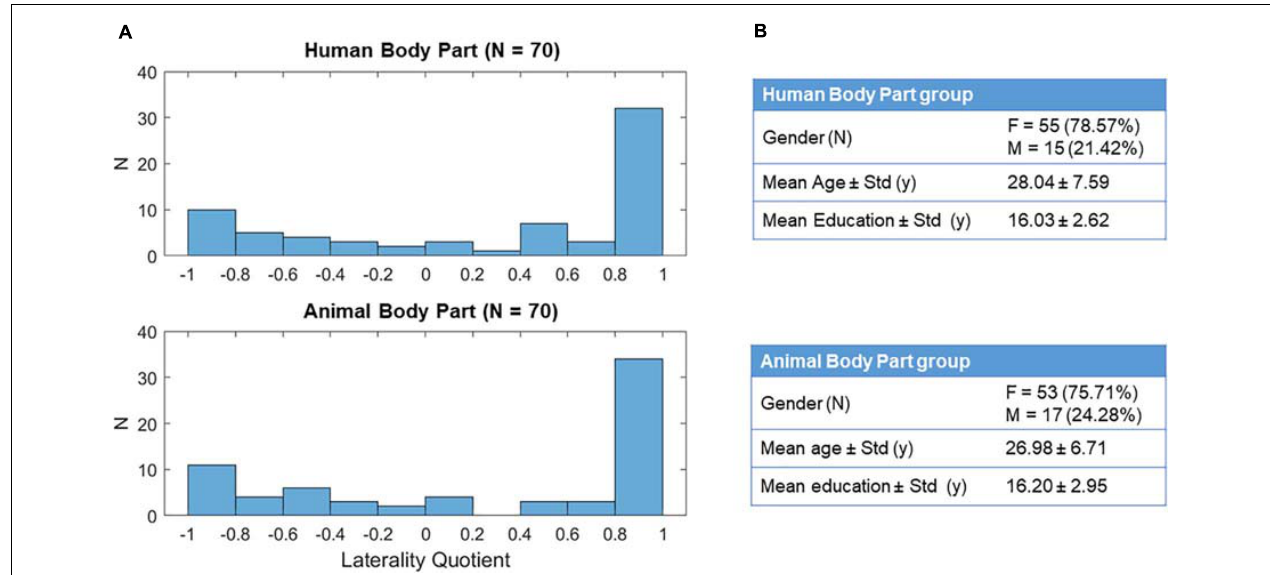
FIGURE 1 | Description of the experimental sample. Panels (A,B) shows, respectively, the distribution of the laterality quotient and the demographic characteristics of the two experimental groups.